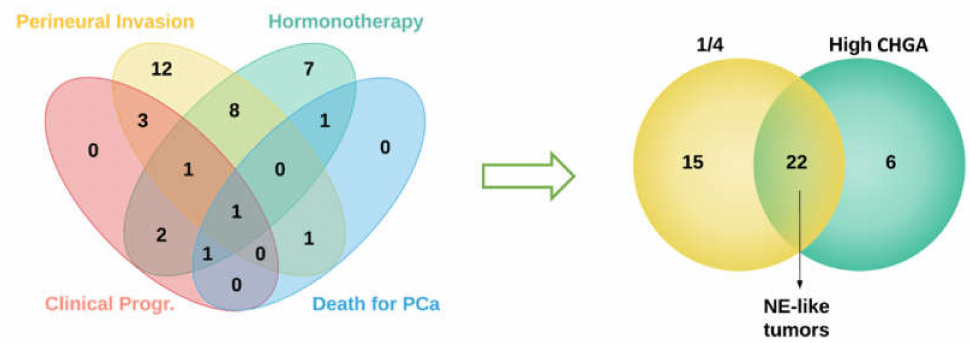
Figure 1. A Venn diagram showing the intersection between di ff erent clinical features of patients with prostate adenocarcinomas (left panel). Tumors from patients who satisfied at least one out four clinical criteria (indicated as 1 / 4 in the right panel) were intersected with tumors with high levels of Chromogranin A expression (right panel).